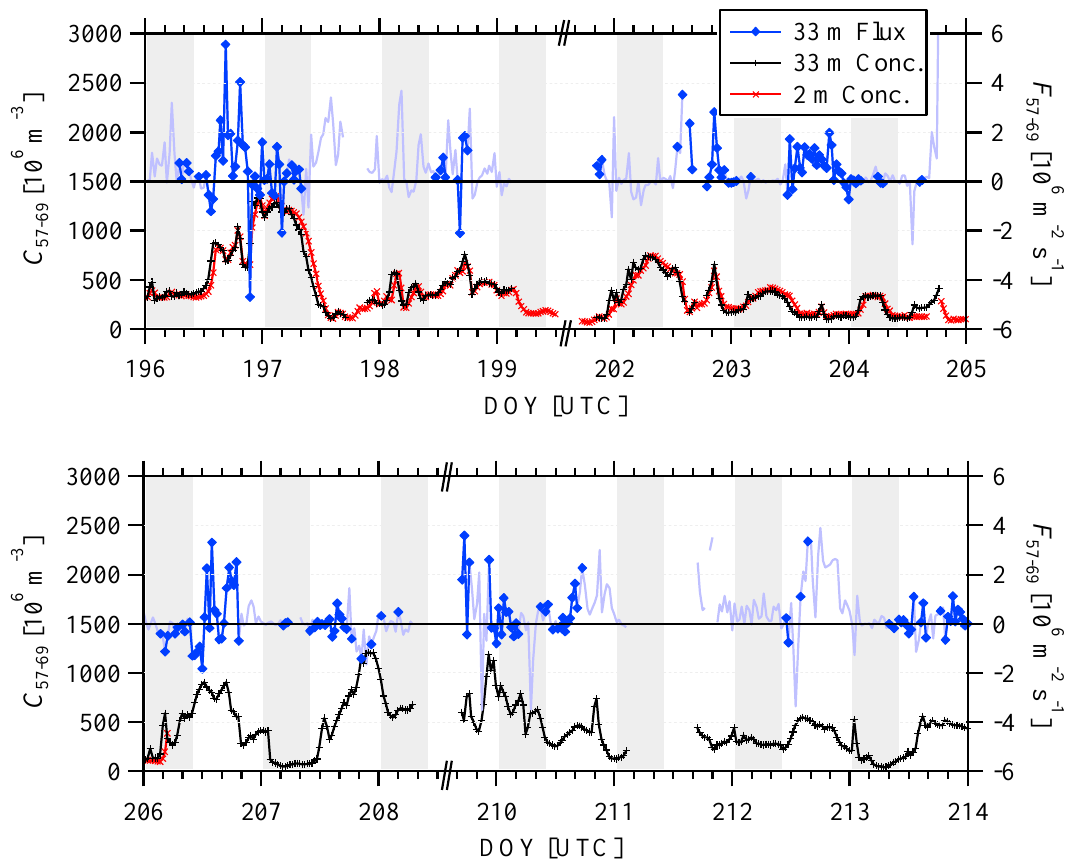
Fig. 11. Concentrations (33m and 2m) and fluxes (33m) for 56.8–68.6nm particles. The light blue line shows fluxes which were removed Figure 11. Concentrations (33 m and 2 m) and fluxes (33 m) for 56.8-68.6 nm particles. The 3 from analysis due to wind direction or low friction velocities. Nights are shaded. light blue line shows fluxes which were removed from analysis due to wind direction or low 4 friction velocities. Nights are shaded. 5